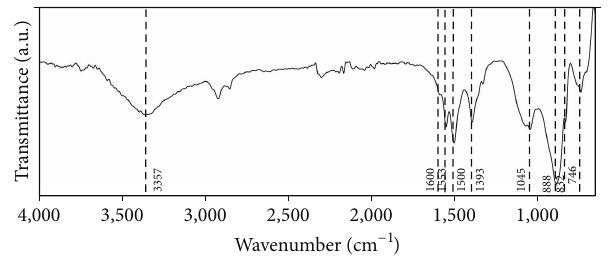
Figure 4: FTIR spectra of ZnO-SiO 2 using 1.0 M NH 4 OH showing the functional groups of silica and